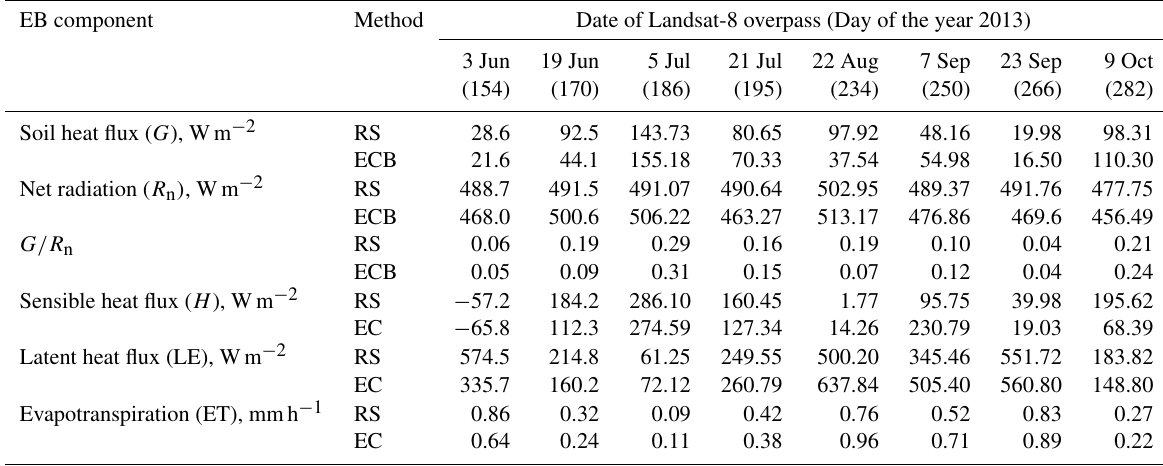
Table 7. EC measured and METRIC-estimated Energy Balance (EB) components over an alfalfa field. EB component